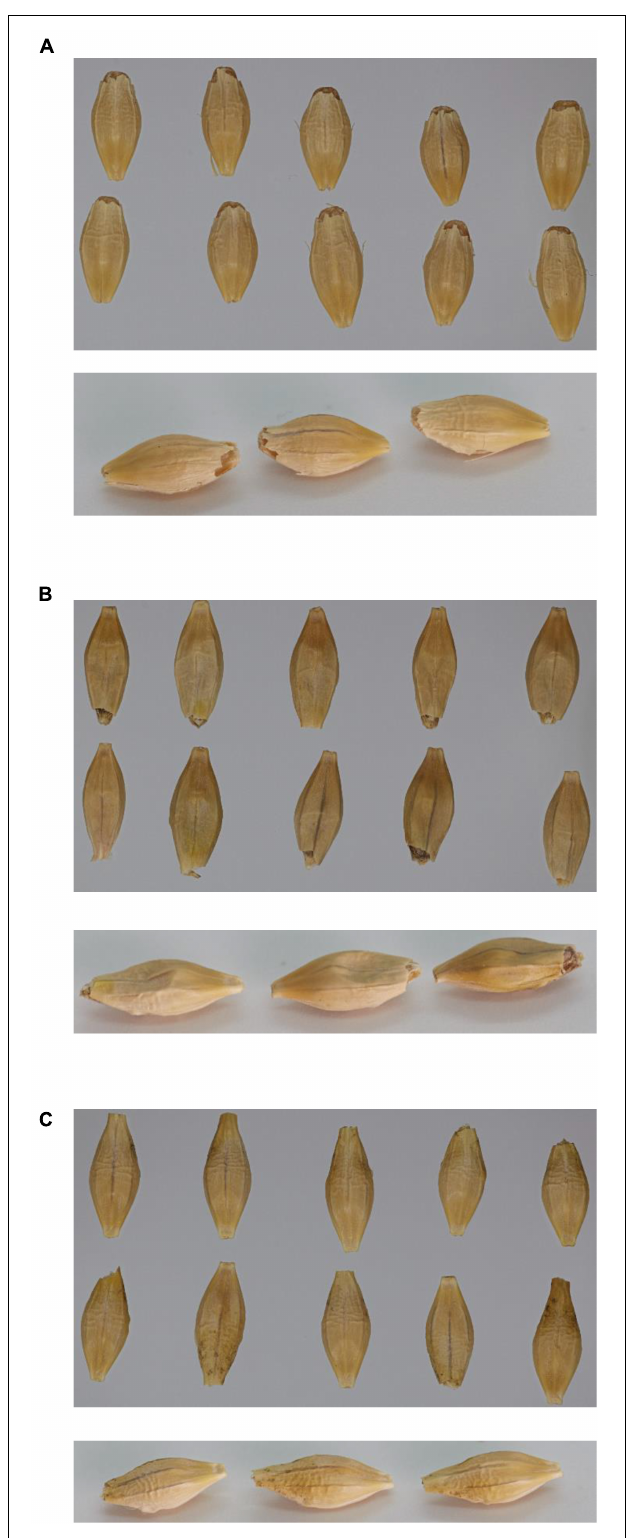
FIGURE 2 | Pictures of 10 mature seeds from above (top picture) and three mature seeds from downward angle (bottom picture). (A) Golden Promise; (B) GP pdi ; (C) GP PDI